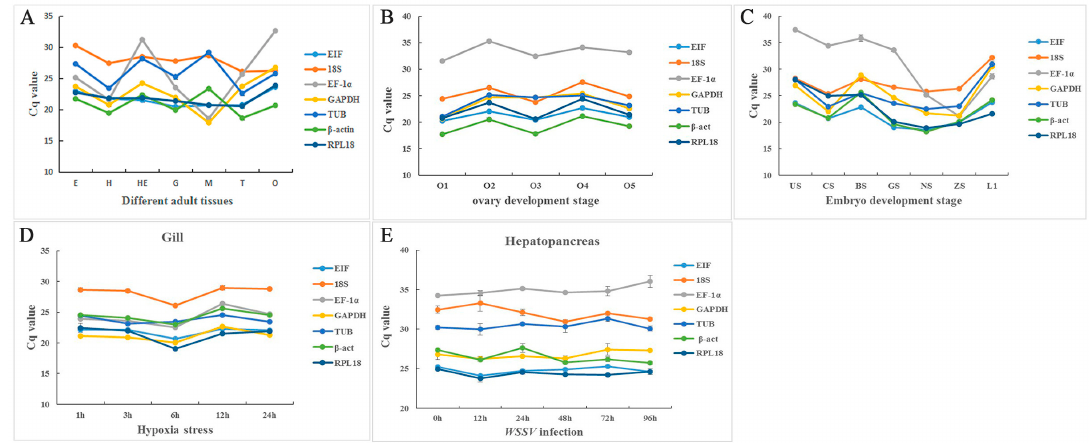
Figure 3. Variation in the reference genes expression using distribution of cycle threshold (Cq) values in line charts. ( A ) Different tissues in adult shrimps. ( B ) Five different ovary development stages, O1–5: Stage I, Stage II, Stage III, Stage IV, and Stage V of ovary. ( C ) Different embryo development stages, US—unfertilized egg stage; CS—cleavage stage; BS—blastula stage; GS—gastrul stage; NS—nauplius stage; ZS—zoea stage; L1—one day after larvae hatched. ( D ) Different times after hypoxia stress in gill. ( E ) Different times after infection in hepatopancreas.